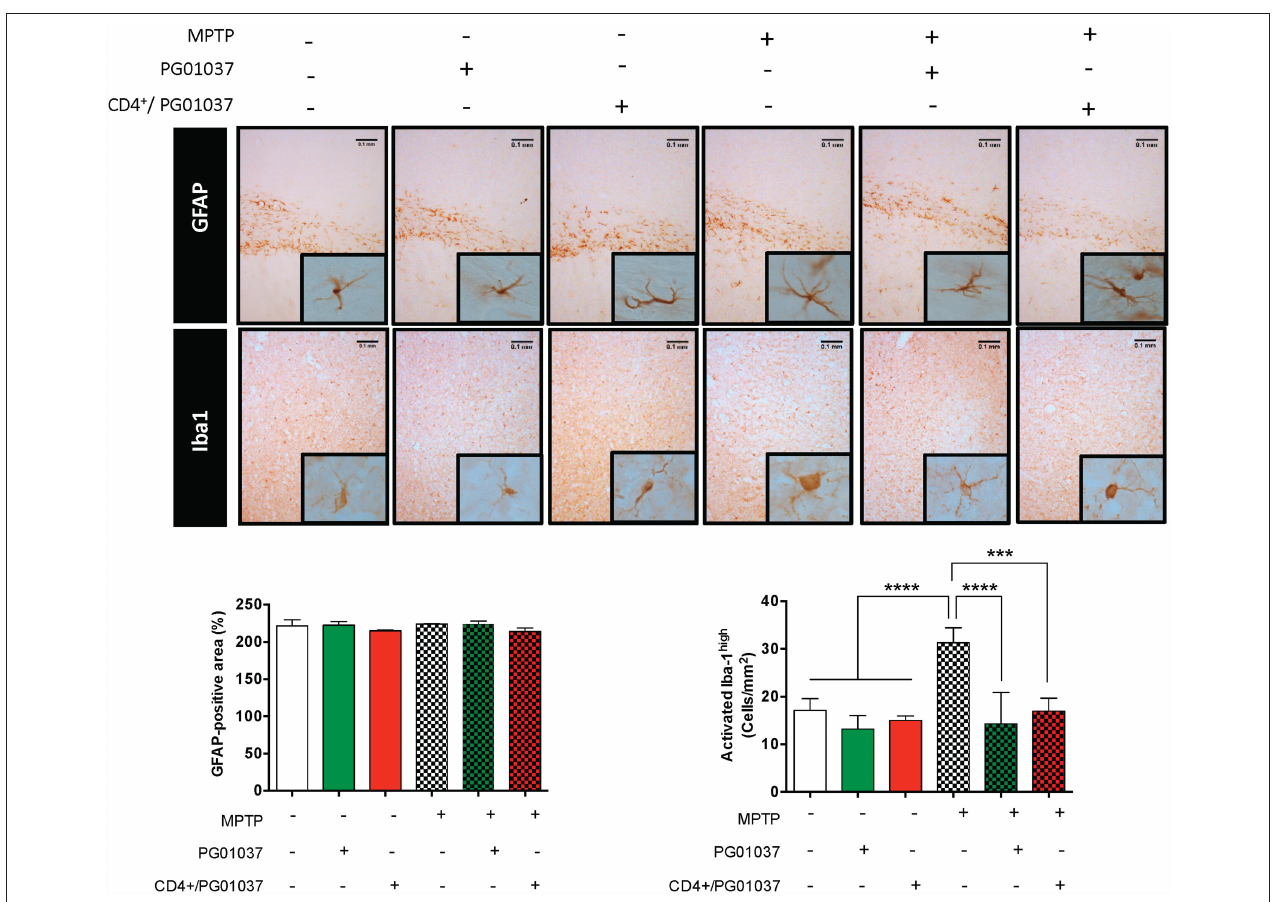
FIGURE 7 | Analysis of neuroinflammation in MPTPp-intoxicated mice upon treatment with systemic DRD3-antagonism or with the intravenous transference of CD4 + T-cells treated with a DRD3 antagonist. CD4 + T-cells (4 × 10 5 cells per mouse) were treated with 20nM PG01037 (red) and then i.v. injected in experimental animals 1 day after the first MPTPp injection. Mice treated with systemic DRD3-antagonism (green) received 9 i.p. injections of PG01037 (30 mg/kg) administered 1 day after MPTPp injections starting after the second MPTPp administration (see scheme in Figure 5A ). Neuroinflammation was analysed 1 week after the last MPTPp injection. Astrogliosis was quantified by immunohistochemical analysis of GFAP and microglial activation was quantified by immunohistochemical analysis of Iba1 in the striatum. Representative overview images of GFAP (top panel) and Iba1 (middle panel) immunostaining are shown. Quantification of GFAP-associated density (bottom-left panel) and the number of Iba1 high cells per area (bottom-right panel) are shown in the bottom panels. Data represent the mean with the SEM from 3 to 5 mice per group. One-way ANOVA followed by Tukey’s multiple comparison post-hoc test were used to determine statistical differences: *** p < 0.001; **** p <